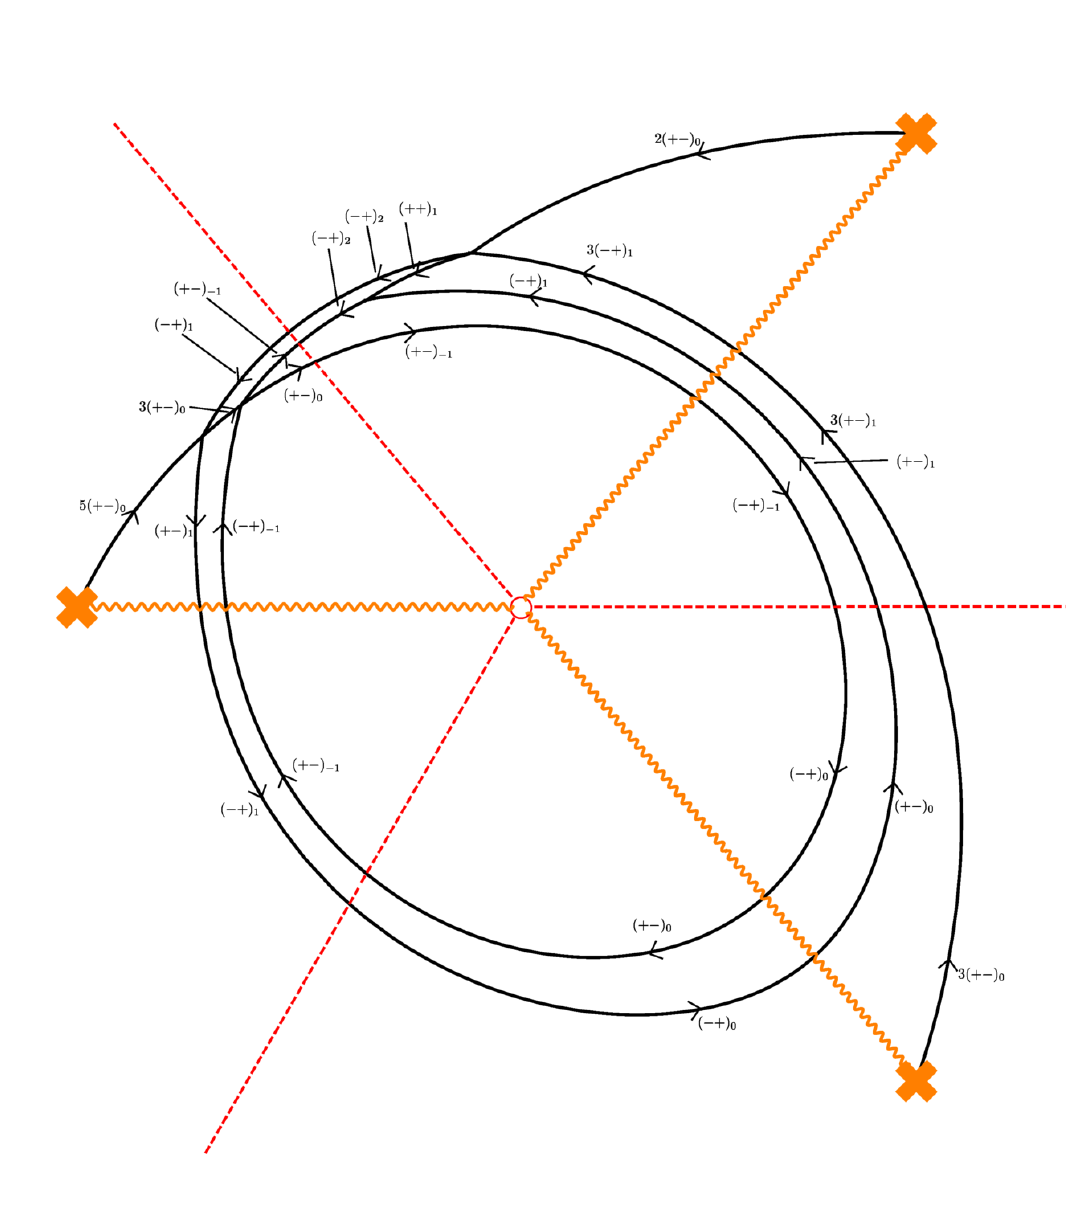
Figure 40. ( ij ) n notation illustrated on the (cid:12)nite web for the (2,5) representation of the Kronecker- 3 quiver.